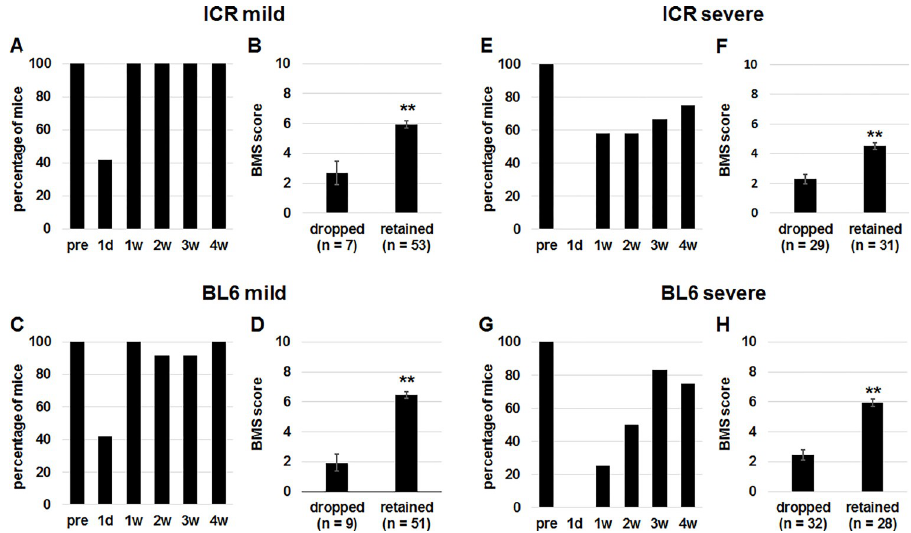
Fig 1. Comparison of BMS scores between mice which fell down from the beam and those which retained on the beam after SCI. (A, C, E, G) Percentages of ICR (A, E) and C57BL/6 (C, G) mice before (pre) and 1 day (d), and 1, 2, 3 and 4 weeks (w) after mild (A, C) and severe (E, G) SCI which did not fall down from the beam during the test. (B, D, F, H) ICR (B, F) and C57BL/6 (D, H) mice 1 day, and 1, 2, 3 and 4 weeks after mild (B, D) and severe (F, H) SCI were divided into those which dropped from the beam and those which retained on the beam and BMS scores of the 2 groups were compared. Mann-Whitney U test, �� p < 0.01.